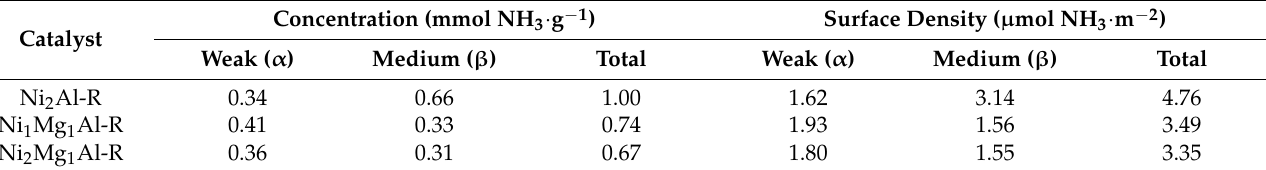
Table 5. Concentration and surface density of weak ( α , T d < 220 °C) and intermediate ( β , 220 °C < T d < 500 °C) acidic sites determined by NH 3 -TPD.